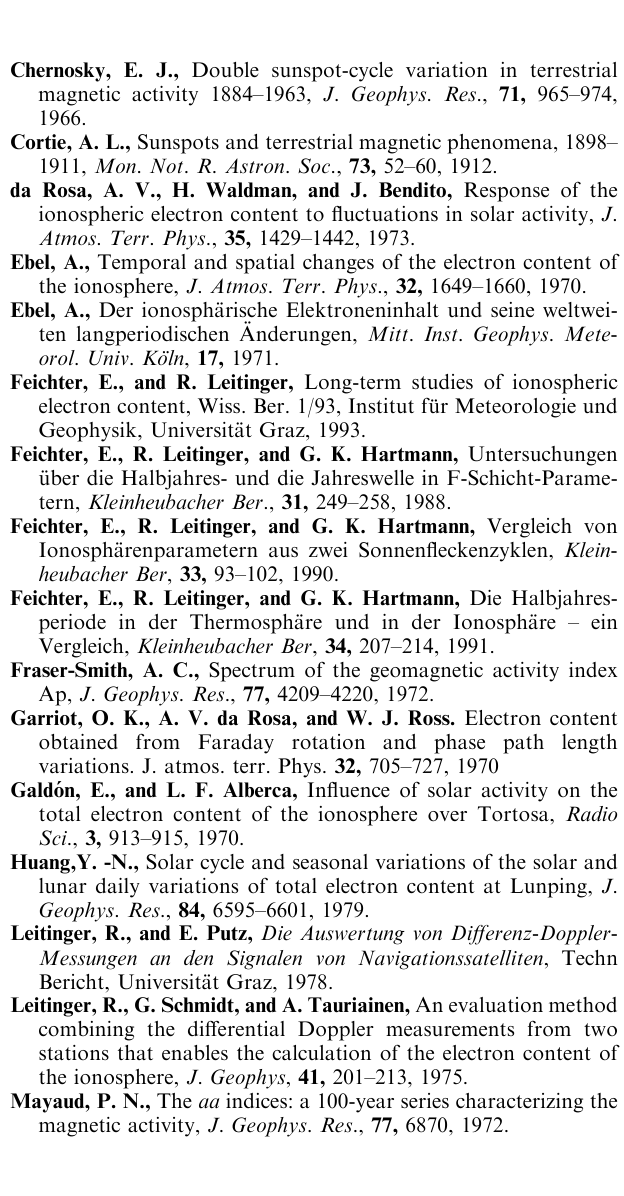
Fig. 8. Annual deviation from mean of the aa index averaged over cycles 18, 20, 22 ( left ) and 19, 21, 23 ( right ). The 1-, 1/2- and 1/3-year components are also shown ( thin